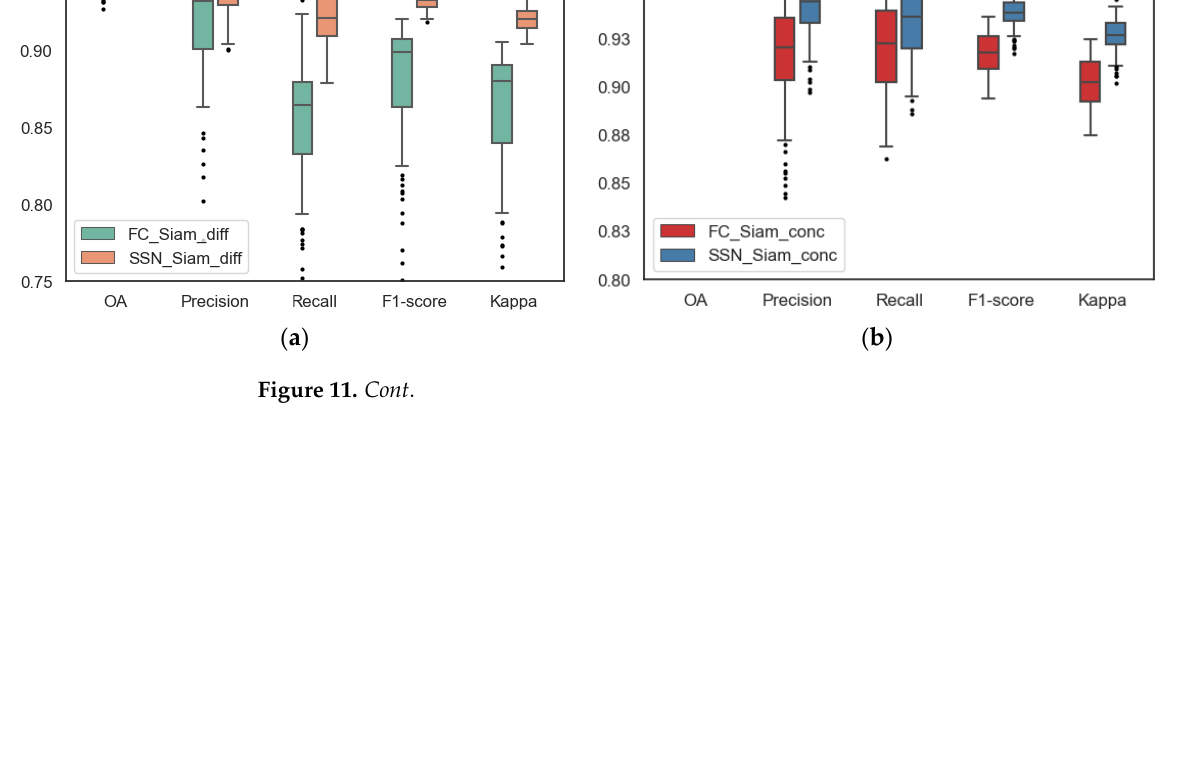
Figure 11. Accuracy indicator distribution of 100 experiments. ( a , b ) refer to the boxplot of FC-Siam- diff vs. SSN-Siam-diff and FC-Siam-conc vs. SSN-Siam-conc for the Ottawa dataset, respectively. Similarly, ( c , d ) correspond to the Sulzberger dataset. 3.3.2. Superpixel Segmentation Results for Bi-Temporal SAR Images We cropped a 256 × 256 area on the Ottawa dataset to display the superpixel seg- mentation results from the SSN-Siam-diff network in Figure 12. The first column is the bi- temporal SAR images, and the middle column corresponds to their superpixel generation results. The third column shows the results where the pixel value is replaced by the mean value of the superpixel to which this pixel belongs. The Ottawa dataset contains winding coastlines and some narrow rivers, which are challenges for superpixel segmentation. For example, in the areas marked in the red box, there are narrow streams of water or land with complex boundaries. In these areas, it is difficult for the superpixel segmentation to perfectly adhere to the boundaries, but the superpixel generation network in our method